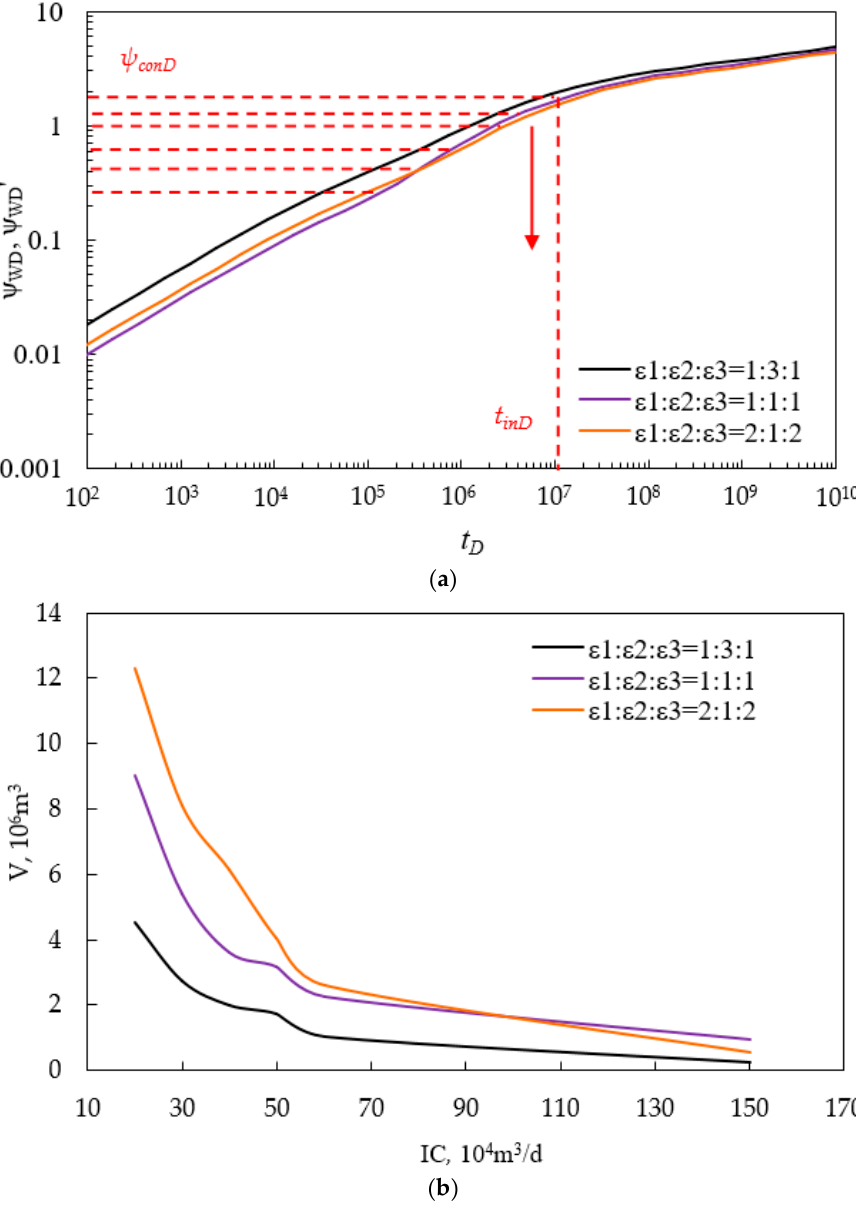
Figure 14. ( a ) Comparison pressure with different IC; ( b ) comparison of CO 2 storage capacity with different IC and ε 1 : ε 2 : ε 3 .